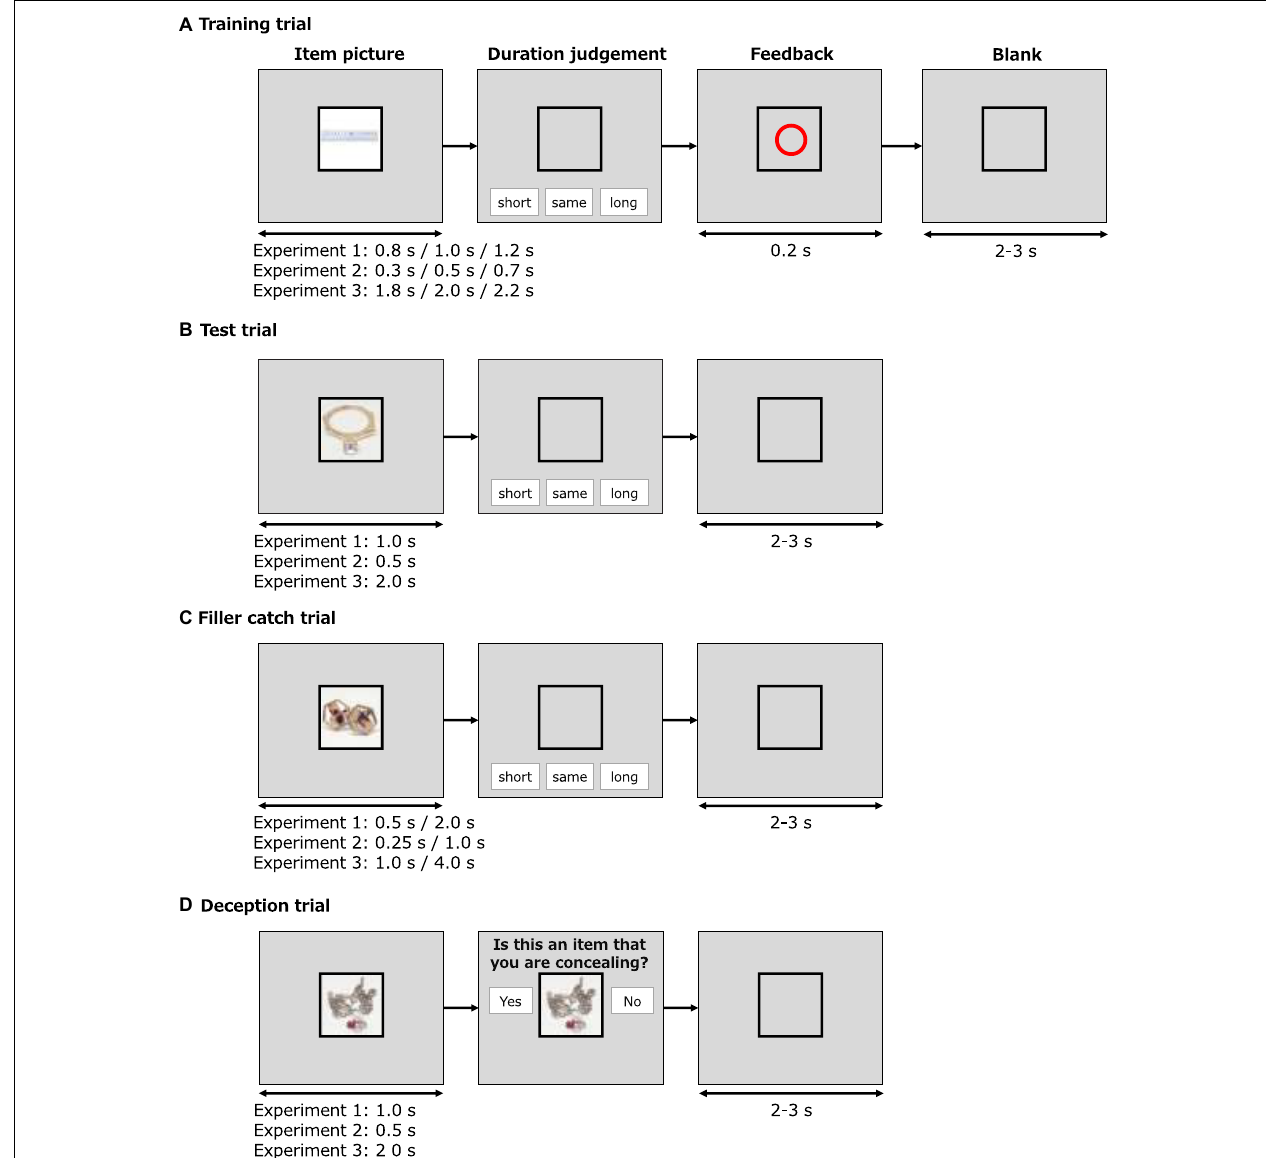
FIGURE 1 | Examples of a trial in the training session and a test trial, a filler catch trial, and a deception trial in the test session. (A) Training trial. (B) Test trial. (C) Filler catch trial. (D) Deception trial.